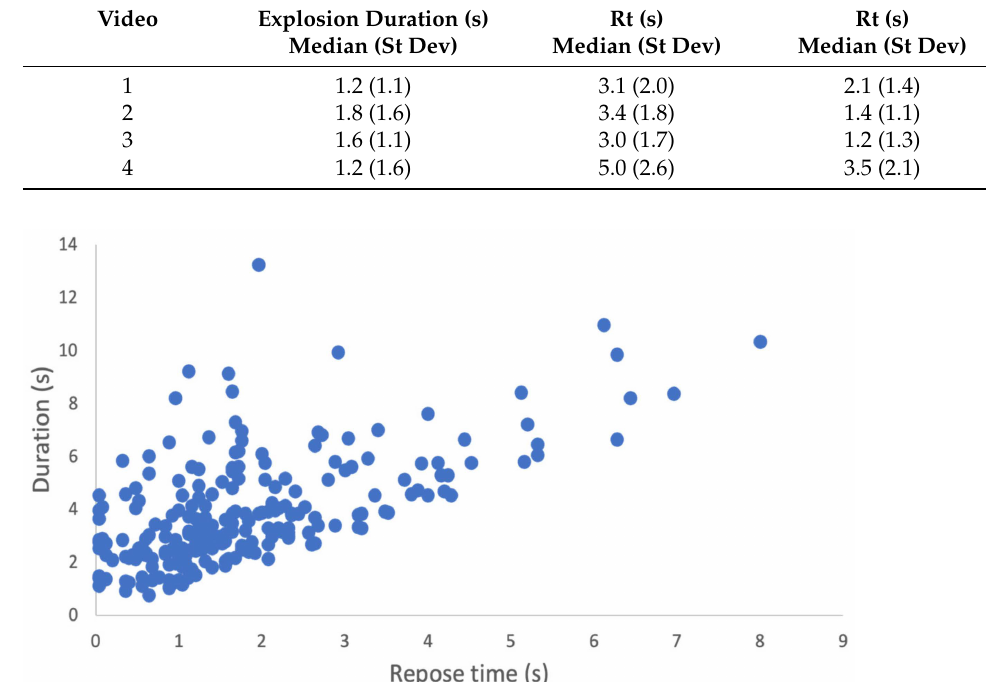
Figure 5. Repose times vs. explosion duration of the explosions studied in this work. Symbols are larger than the error associated to